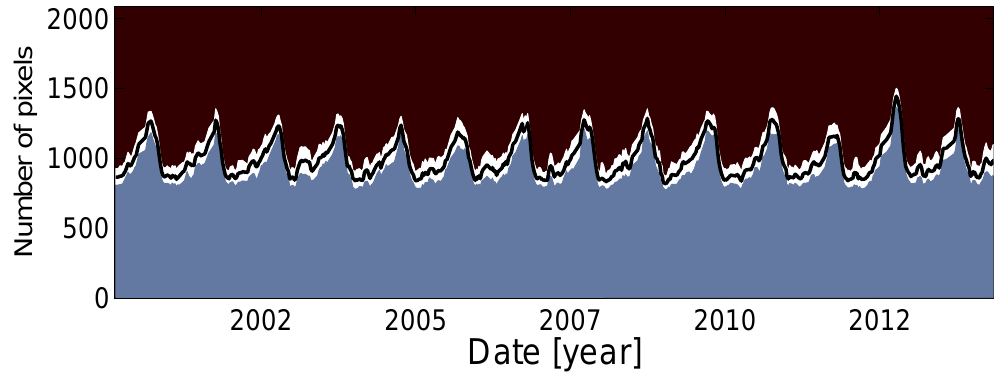
Figure 17. Water and land pixels present in blue and dark brown, respectively. The number of pixels with less than 10% marginal probability are shown in white. The black line represents the maximum a posteriori (MAP) solution in the graph. Monitoring period: February 2000–September 2014.